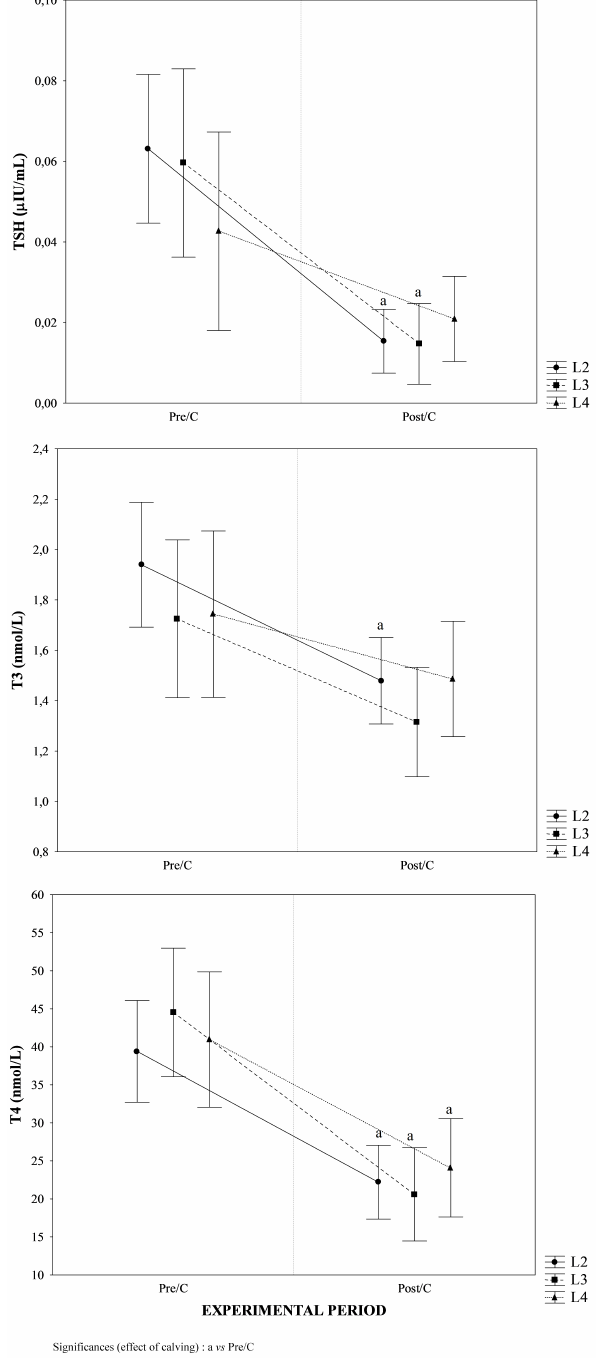
Figure 1. Statistically significant effects of period (pre-calving, post-calving) on TSH, T3 and T4 recorded during the transition pe- riod in Holstein dairy cows. Vertical bars report 95% conference